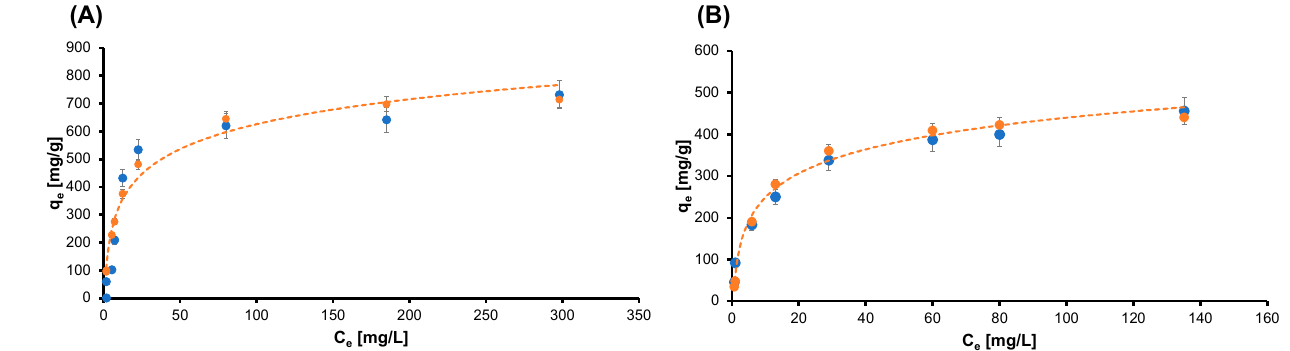
Figure 3. Plot of the collected data and experimental model for the isotherm curve of ( A ) CBY and ( B ) IC. Blue dots are the experimental data, and the orange curve is the Langmuir model. Data are presented as means ± standard deviations.